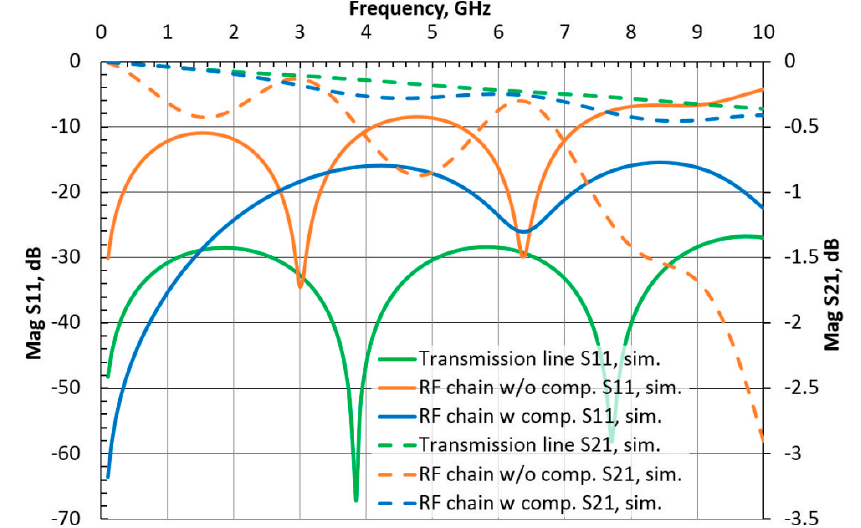
Figure 6. Simulated amplifier chain S 11 and S 21 responses.